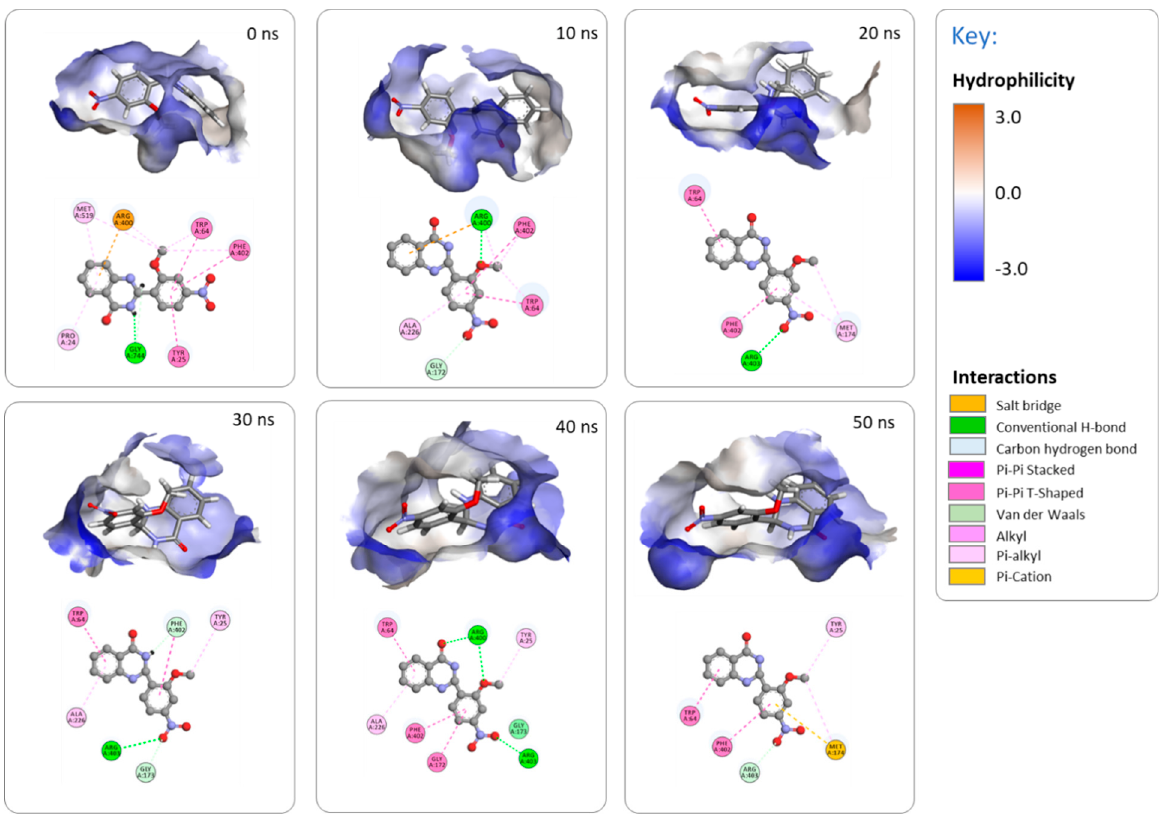
Figure 4. The 3D snapshots of the simulated BioA- 3m complex at different time points along with their respective 2D interaction maps. Compound 3m is shown in balls and sticks. The 2D interaction maps show the interactions of compound 3m with BioA binding site. Coloring is as in Figure 2.